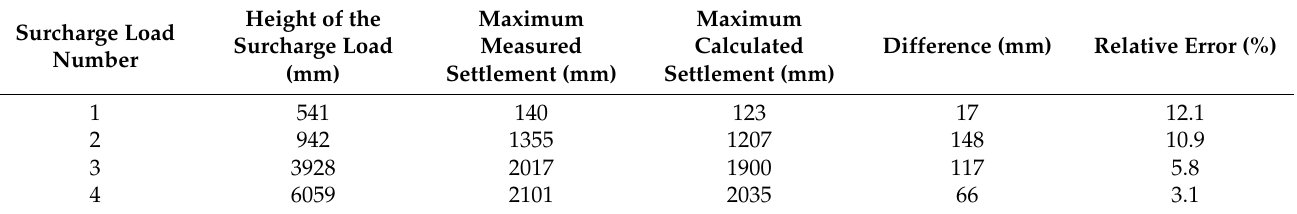
Table 7. Comparison of the calculated and measured settlement